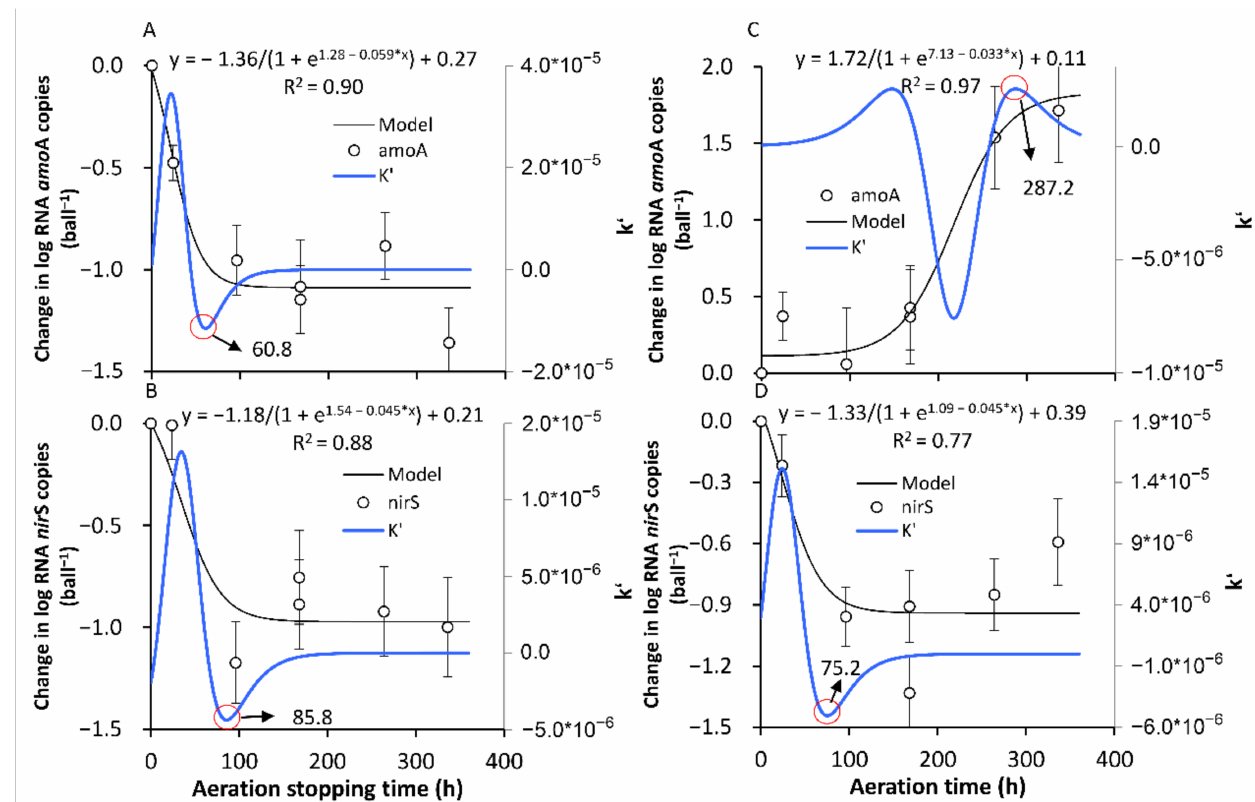
Figure 9. The formation processes of the new stable states of the RNA level abundance of nitrogen-cycle functional genes amo A and nir S after the transformation between aeration and no aeration. ( A , B ) show the formation of SS-AN amo A and SS-AN nir S , respectively, in the AE-D reactors; ( C , D ) show the formation of SS-AE amo A and SS-AE nir S , respectively, in the AN-D reactors. The red circle is the position of the inflection point, and the number indicated by the arrow is the corresponding time of the inflection point. (sample number: